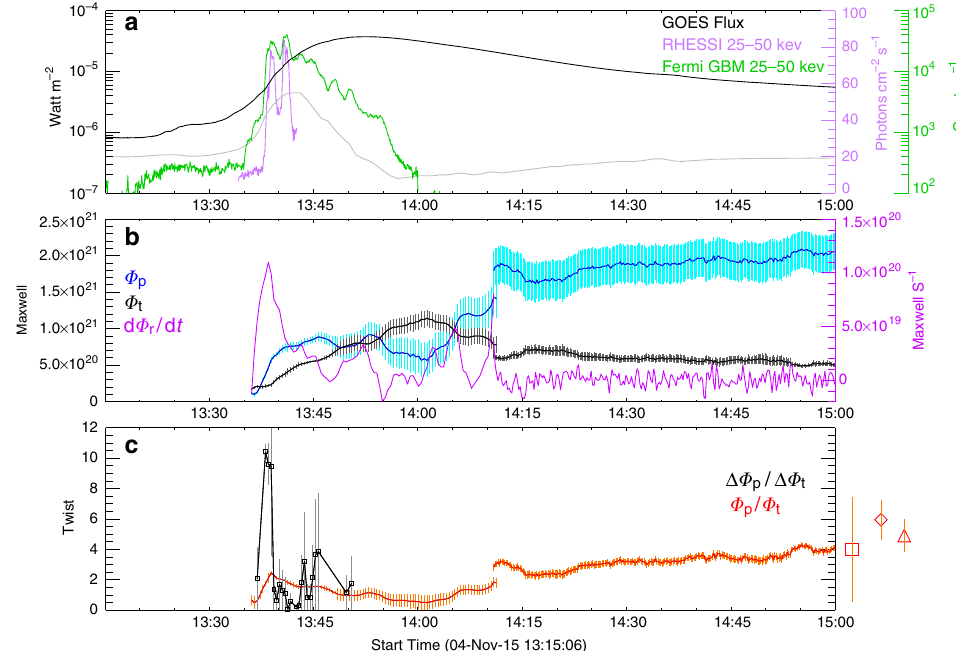
Fig. 6 Temporal evolution of the poloidal and toroidal fl uxes in the magnetic fl ux rope. a 0.1 – 0.8 nm soft X-ray fl ux observed by the Geostationary Operational Environmental Satellite (GOES), its time derivative in an arbitrary unit (gray), 25 – 50 keV hard X-ray (HXR) count rate observed by the Gamma-ray Burst Monitor (GBM) onboard the Fermi Gamma-Ray Space Telescope, and 25 – 50 keV HXR photon fl ux observed by the Reuven Ramaty High-Energy Solar Spectroscopic Imager (RHESSI). b Poloidal fl ux Φ p and toroidal fl ux Φ t of the magnetic fl ux rope. Also shown is the time derivative of reconnection fl ux Φ r = Φ p + Φ t . c Twist number of the magnetic fl ux rope as gauged by Φ p / Φ t and Δ Φ p / Δ Φ t . Marked on the right are Φ p / Φ t given by the Gold-Hoyle (square) and Lundquist (diamond) fi ttings and the Grad-Shafranov reconstruction (triangle; Methods section) of the interplanetary magnetic cloud, with the values and error bars given in Supplementary Table 1 (Methods section). Error bars of Φ p and Φ t are given by varying the detection threshold of the corresponding features (Methods section), and those of Φ r , Φ p / Φ t , and Δ Φ p / Δ Φ t are derived following the error propagation